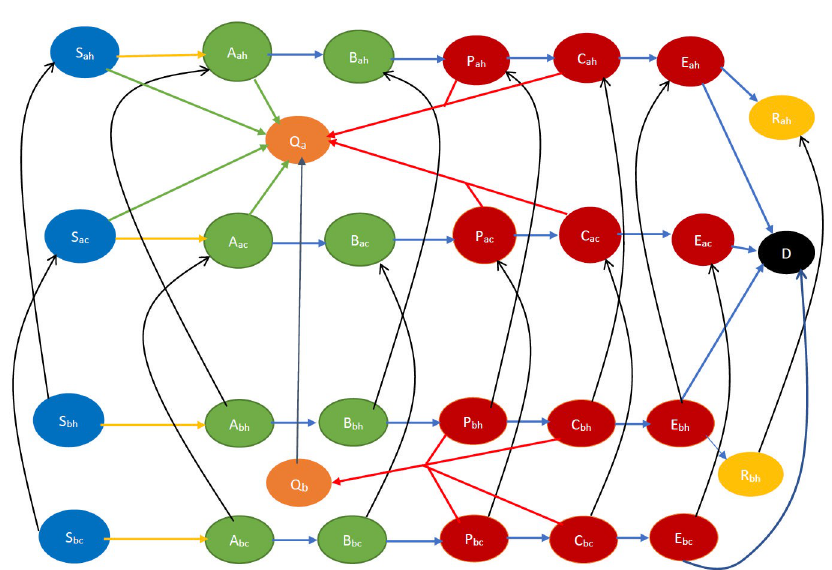
Fig 4. Smallpox disease progression overview for both drug and vaccine scenario. The states colored orange are the preempted states. Every other state and transition has the same meaning as described in the caption for Fig 3.